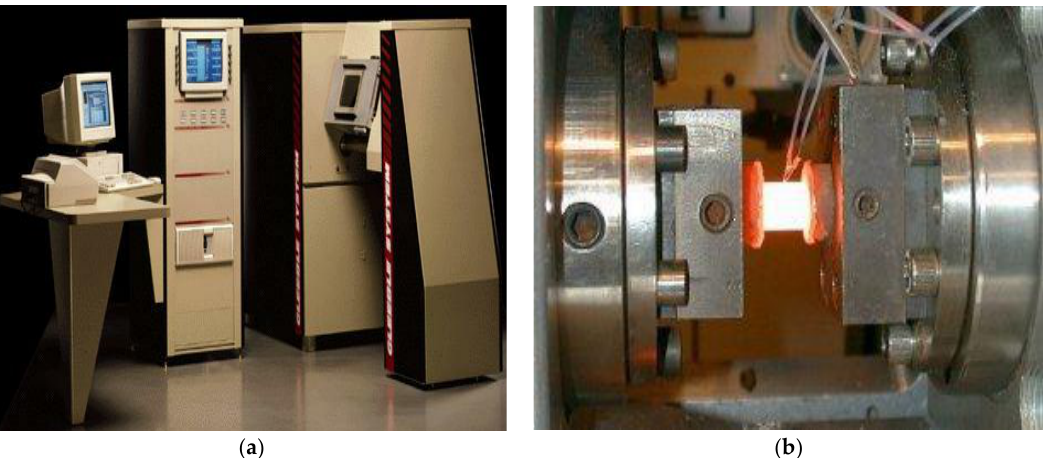
Figure 2. Experimental equipment and condition of the isothermal compression tests: ( a ) Gleeble 3500 testing machine; ( b ) experimental process.